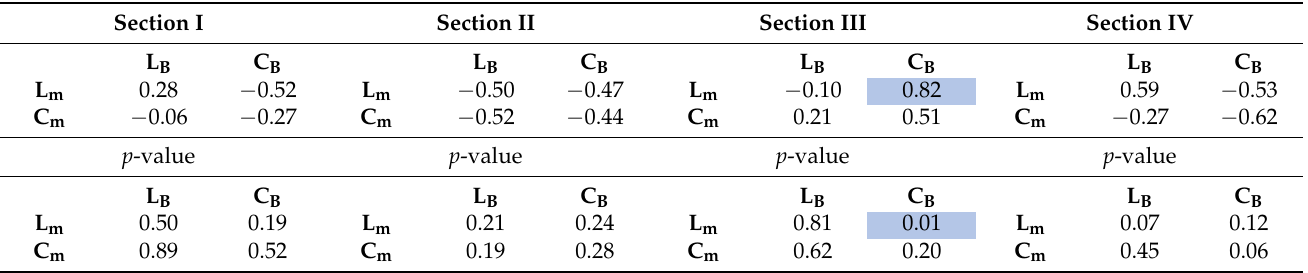
Table 5. Correlations between the lightness (L) and chroma (C) of the main (m) and background (b) colors in Sections I, II, III, and IV.